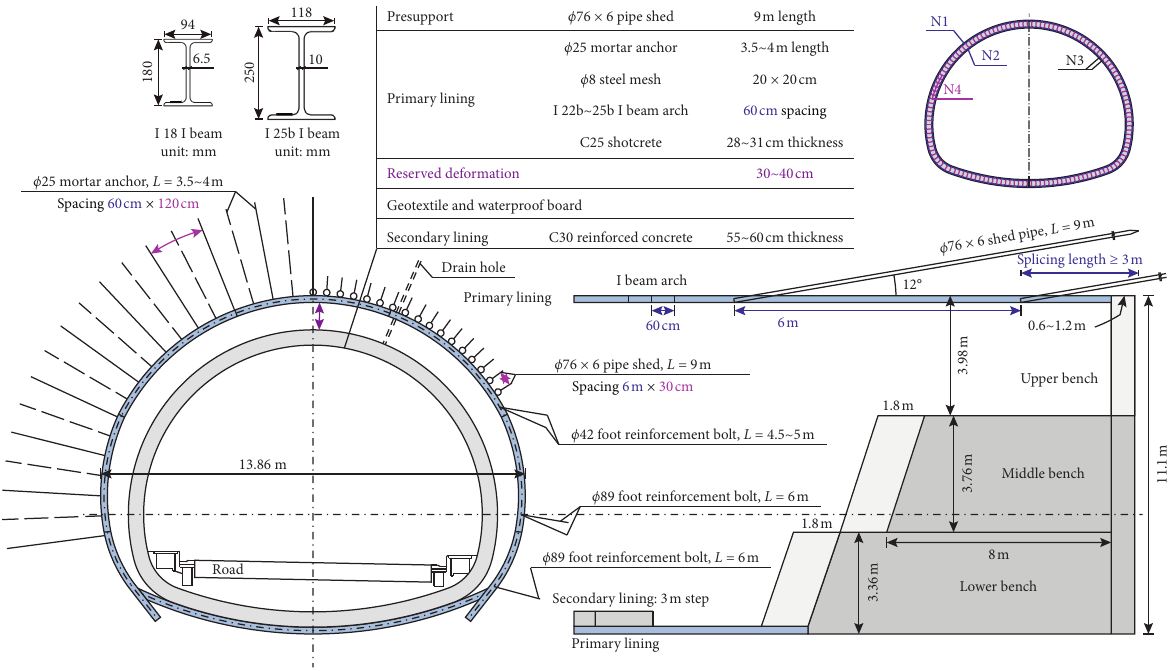
Figure 14: Schematic diagram of the dynamically adaptive support system in talus-like formations adopted in Tayi tunnel.